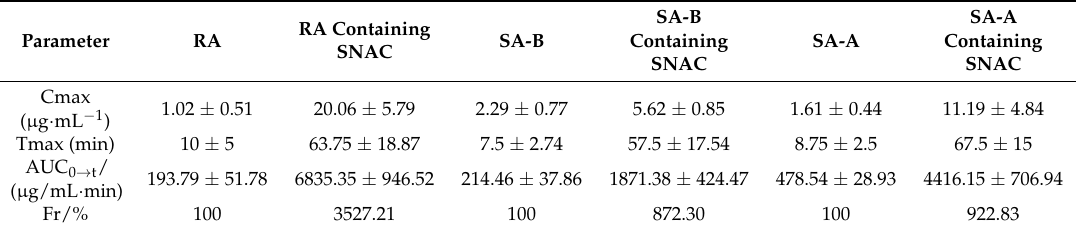
Table 2. Pharmacokinetic parameters of RA, SA-B and SA-A after oral administration of SAs and SAs containing SNAC ( n =